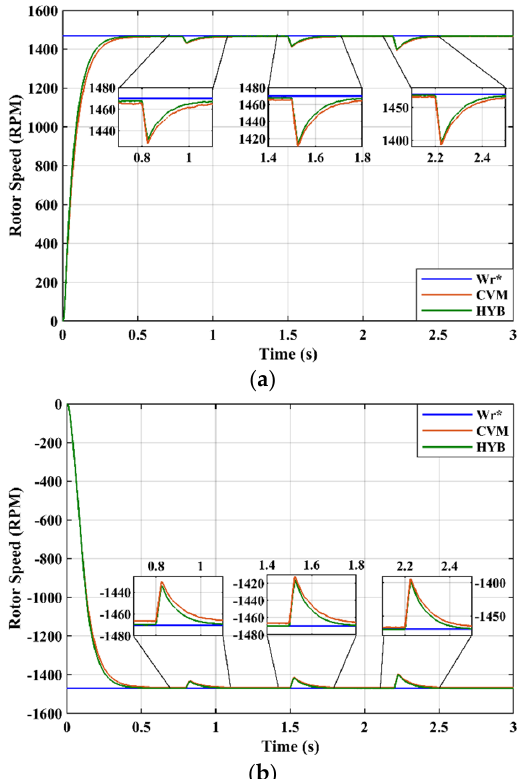
Figure 19. Rotor speed response under load torque disturbances: ( a ) in forward operation and ( b ) in reverse operation.